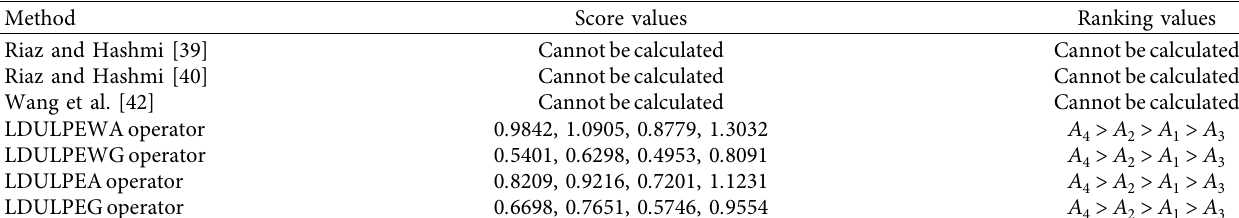
Table 5: Comparative analysis of the elaborated operators and existing